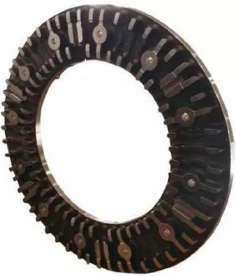
Figure 1. Brake disc material [4].